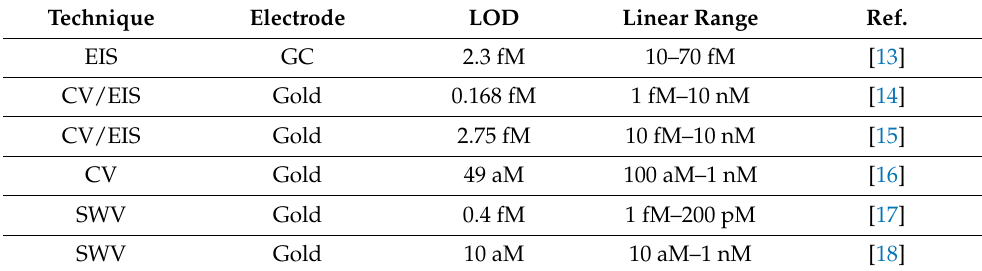
Table 1. Recent electrochemical biosensors for miRNA 21 detection.